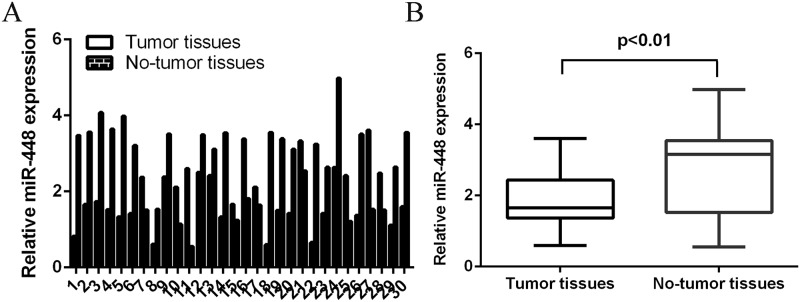
miR-448 expression level was downregulated in osteosarcoma tissues.(A) The expression level of miR-448 in the osteosarcoma tissues and their related normal tissues was determined by qRT-PCR. (B) The expression level of miR-448 was lower in osteosarcoma tissues compared to that in the related normal tissues.